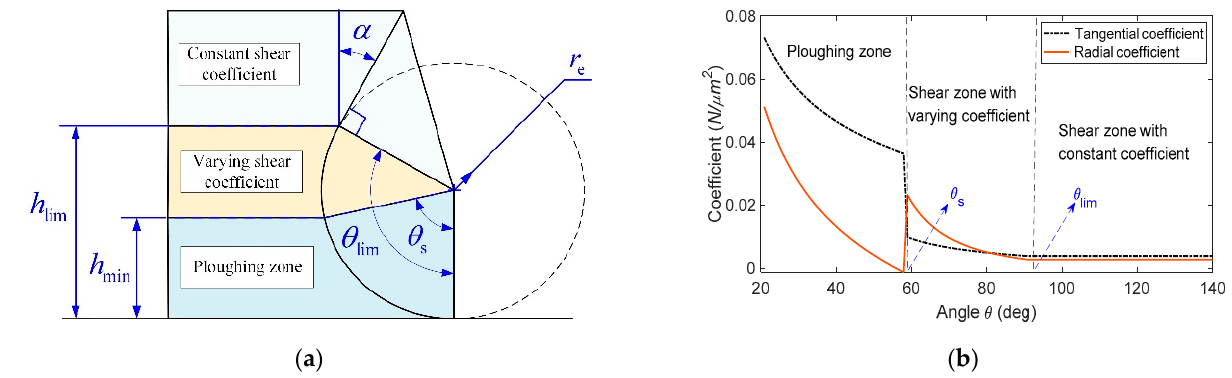
Figure 4. The nonlinear cutting force coefficient function. ( a ) The division of the cutting zone; ( b ) the nonlinear cutting force coefficient in three different cutting regions.